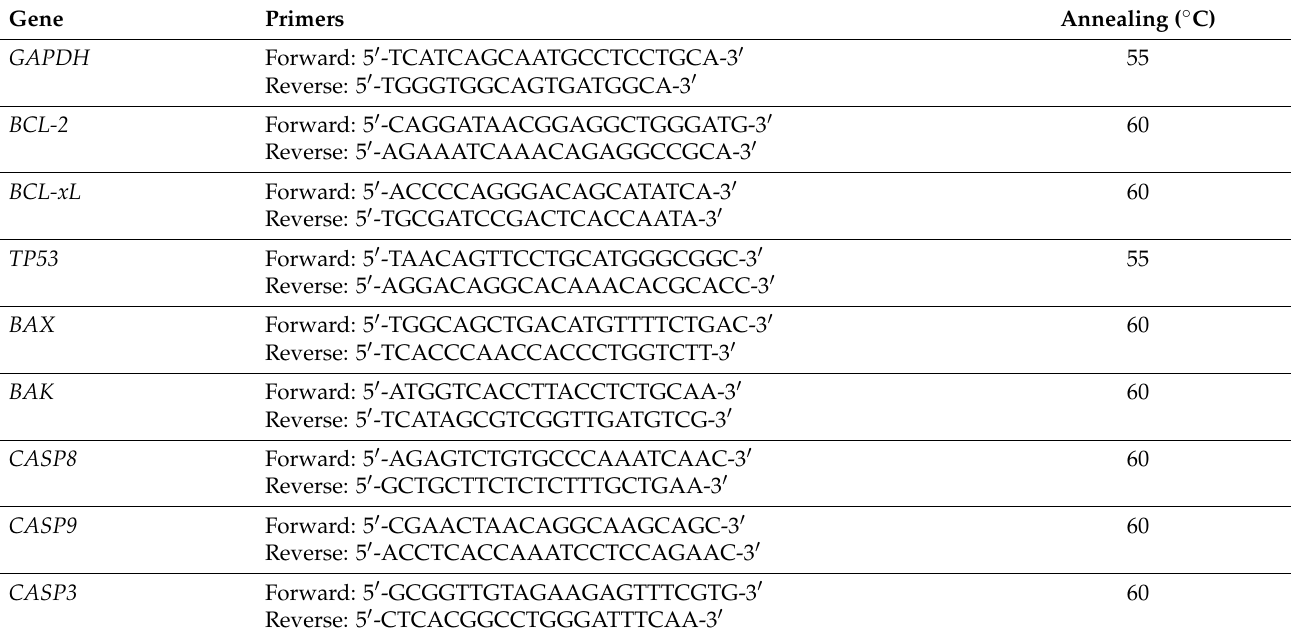
Table 1. PCR primer sequences used in